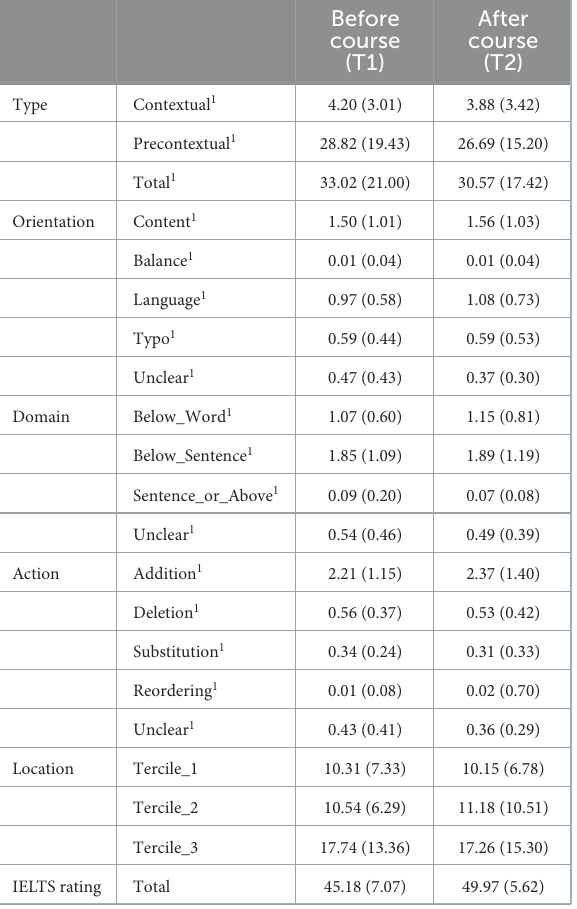
TABLE 3 Descriptive statistics over time–mean